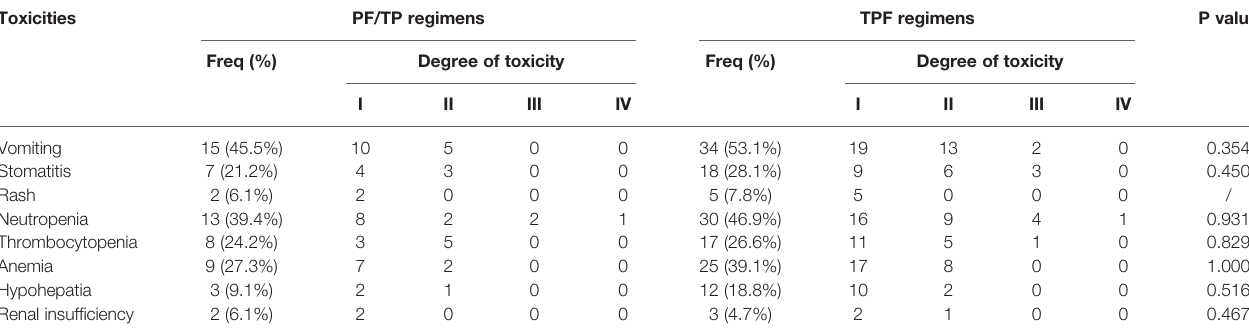
TABLE 7 | Toxicities induced by chemotherapy in patients receiving larynx preservation regimens.